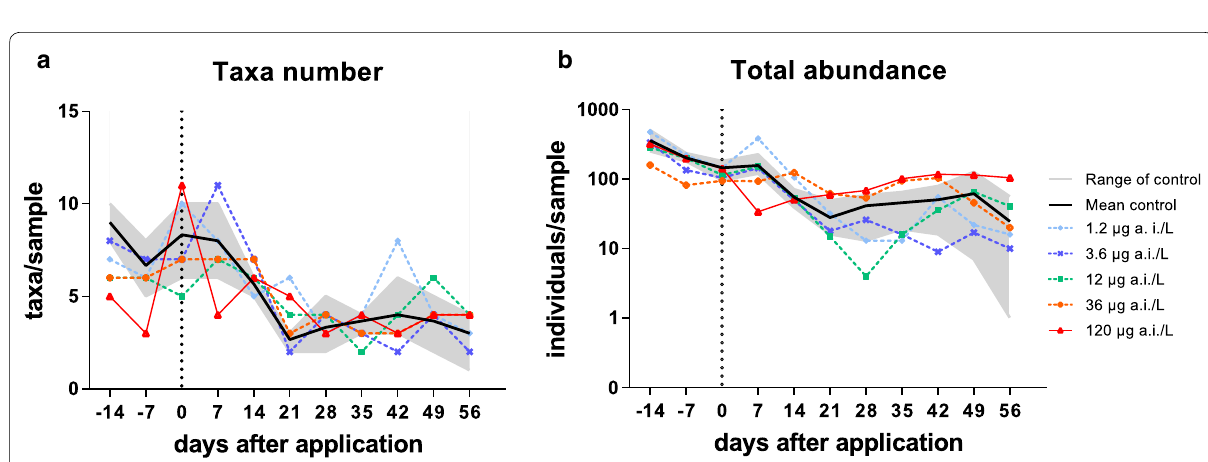
Fig. 8 a Number of taxa and b total abundance in emergence traps; dashed line: time point of